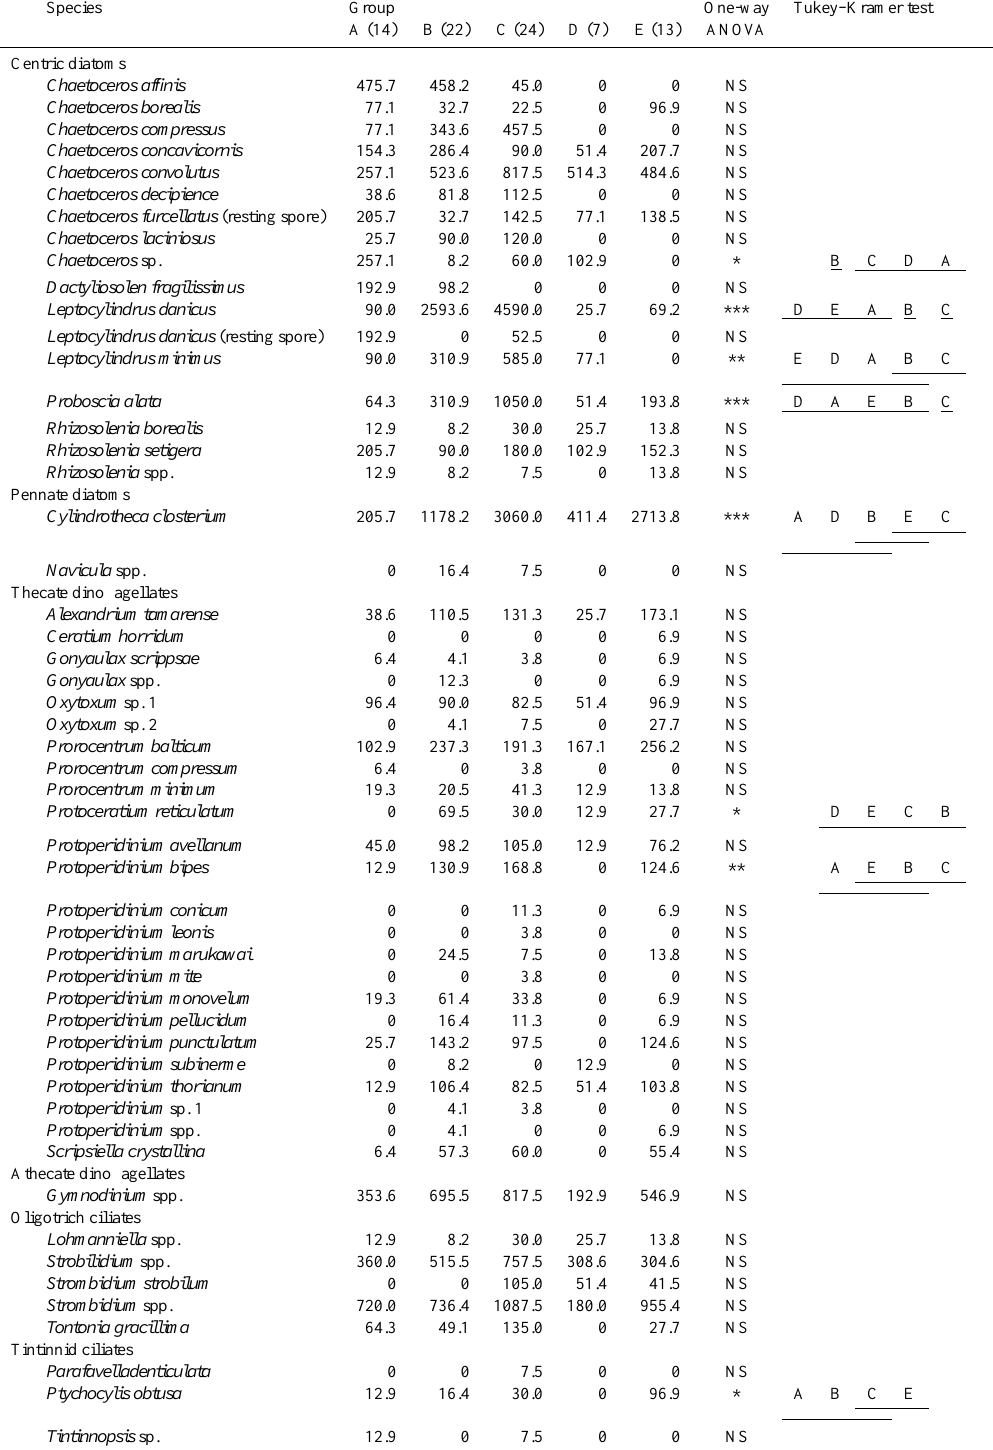
Table 2. Mean cell densities (cellsL − 1 ) of microplankton in each group identified by cluster analysis (cf. Fig. 6) in the Chukchi Sea between 10 and 25 September 2013. Numbers in parentheses indicate the number of samples included. Differences between groups were tested by one-way ANOVA and the Tukey–Kramer test. Any groups not connected by the underlines are significantly different ( p < 0 . 05). NS: not significant; *: p < 0 . 05; **: p < 0 . 01; ***: p < 0 . 001.